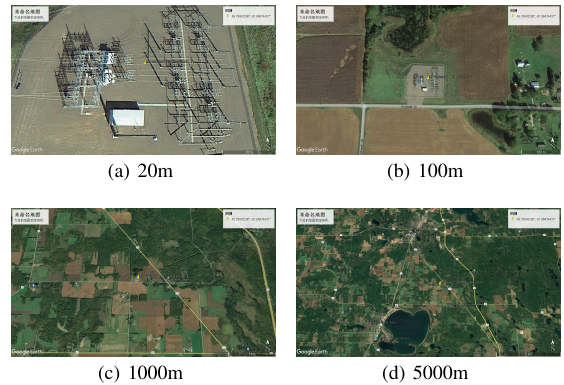
Figure 6. Image samples in datasets made by